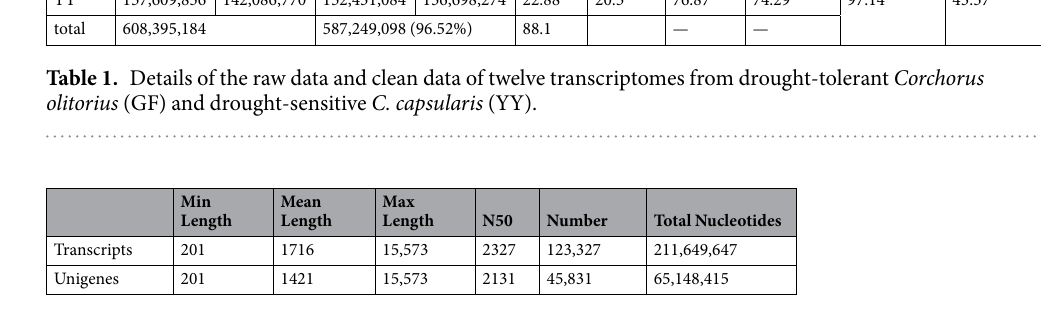
Table 2. Assembly output statistics of all clean data using Trinity